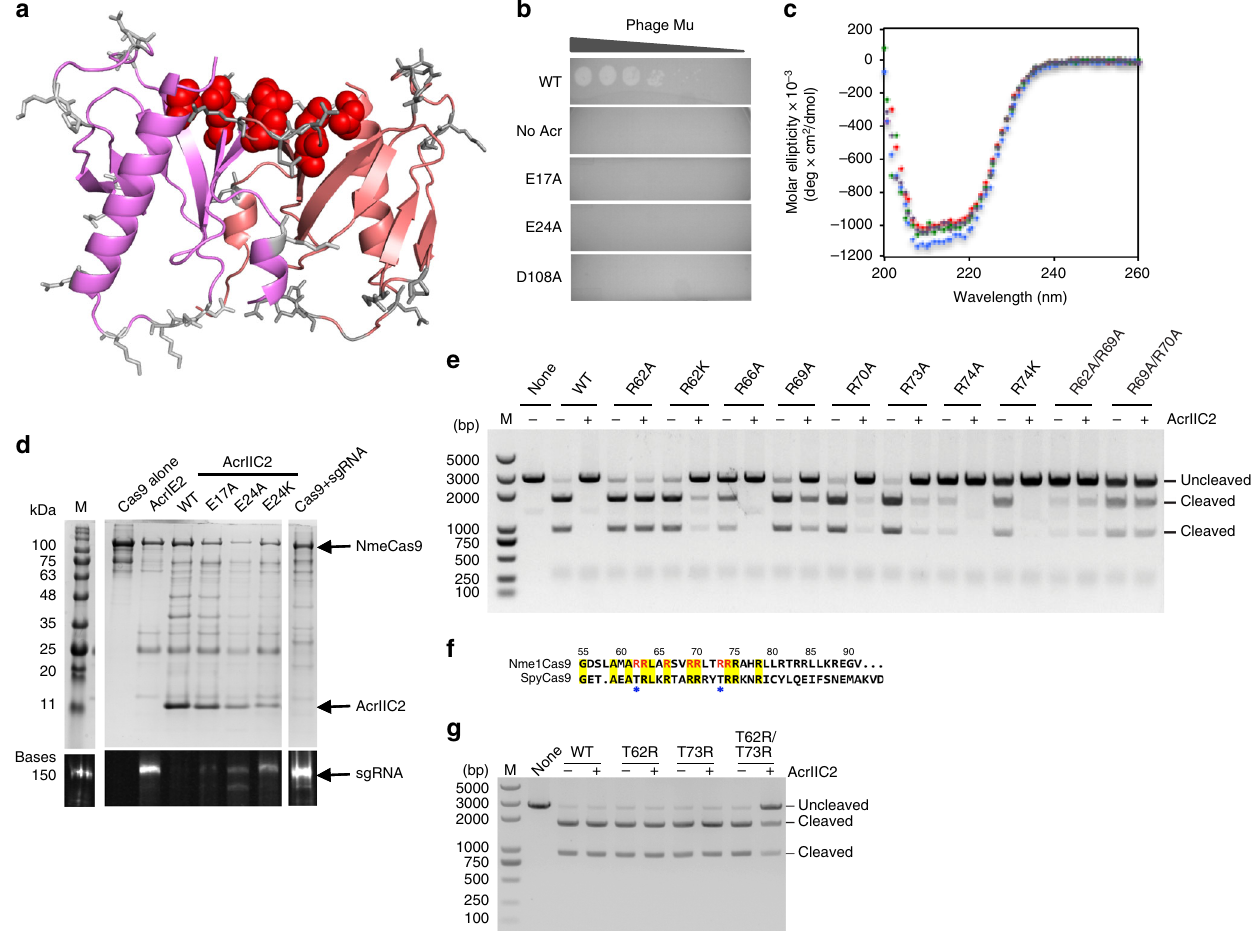
Fig. 4 AcrIIC2 Nme activity is mediated through a large electronegative surface. a AcrIIC2 Nme surface-exposed residues targeted for site-directed mutagenesis are shown on the surface of the protein. The side chain positions at which amino acid substitutions did not affect activity are shown in gray, while the three residues that showed the large decrease in activity when substituted are shown in red. b Representative results of the in vivo phage plaque assay. Serial dilutions of phage Mu plated on E. coli reveal that E17A, E24A, and D108A mutants have lost the ability to inhibit CRISPR-Cas9. c Representative circular dichroism spectroscopy scans of wild type anti-CRISPR (red) and three inactive mutants (E17A, blue; E24A, green; D108A, purple) show that the inactive mutants maintain their secondary structure. d Co-puri fi cation of AcrIIC2 Nme mutants with 6x-His-tagged Nme1Cas9 reveals decreased binding of the inactive anti-CRISPRs to Nme1Cas9, and corresponding increase in the amount of Cas9-bound sgRNA. e In vitro DNA cleavage assays with wild type Nme1Cas9 and the site-directed mutants in the bridge helix domain in the presence and absence of AcrIIC2 Nme . f Sequence alignment of the bridge helix of Nme1Cas9 and SpyCas9. The residue numbers of Nme1Cas9 are shown above the sequence. The amino acids that are identical in both Nme1Cas9 and SpyCas9 are shown with yellow background. The Nme1Cas9 amino acids that interact with AcrIIC2 Nme are shown in red. Residues T62 and T73 of SpyCas9 are highlighted by blue stars. g DNA cleavage assay with the wild type or mutant SpyCas9 either in the presence or absence of AcrIIC2 Nme to test whether AcrIIC2 Nme protein inhibits the activity of SpyCas9 mutants